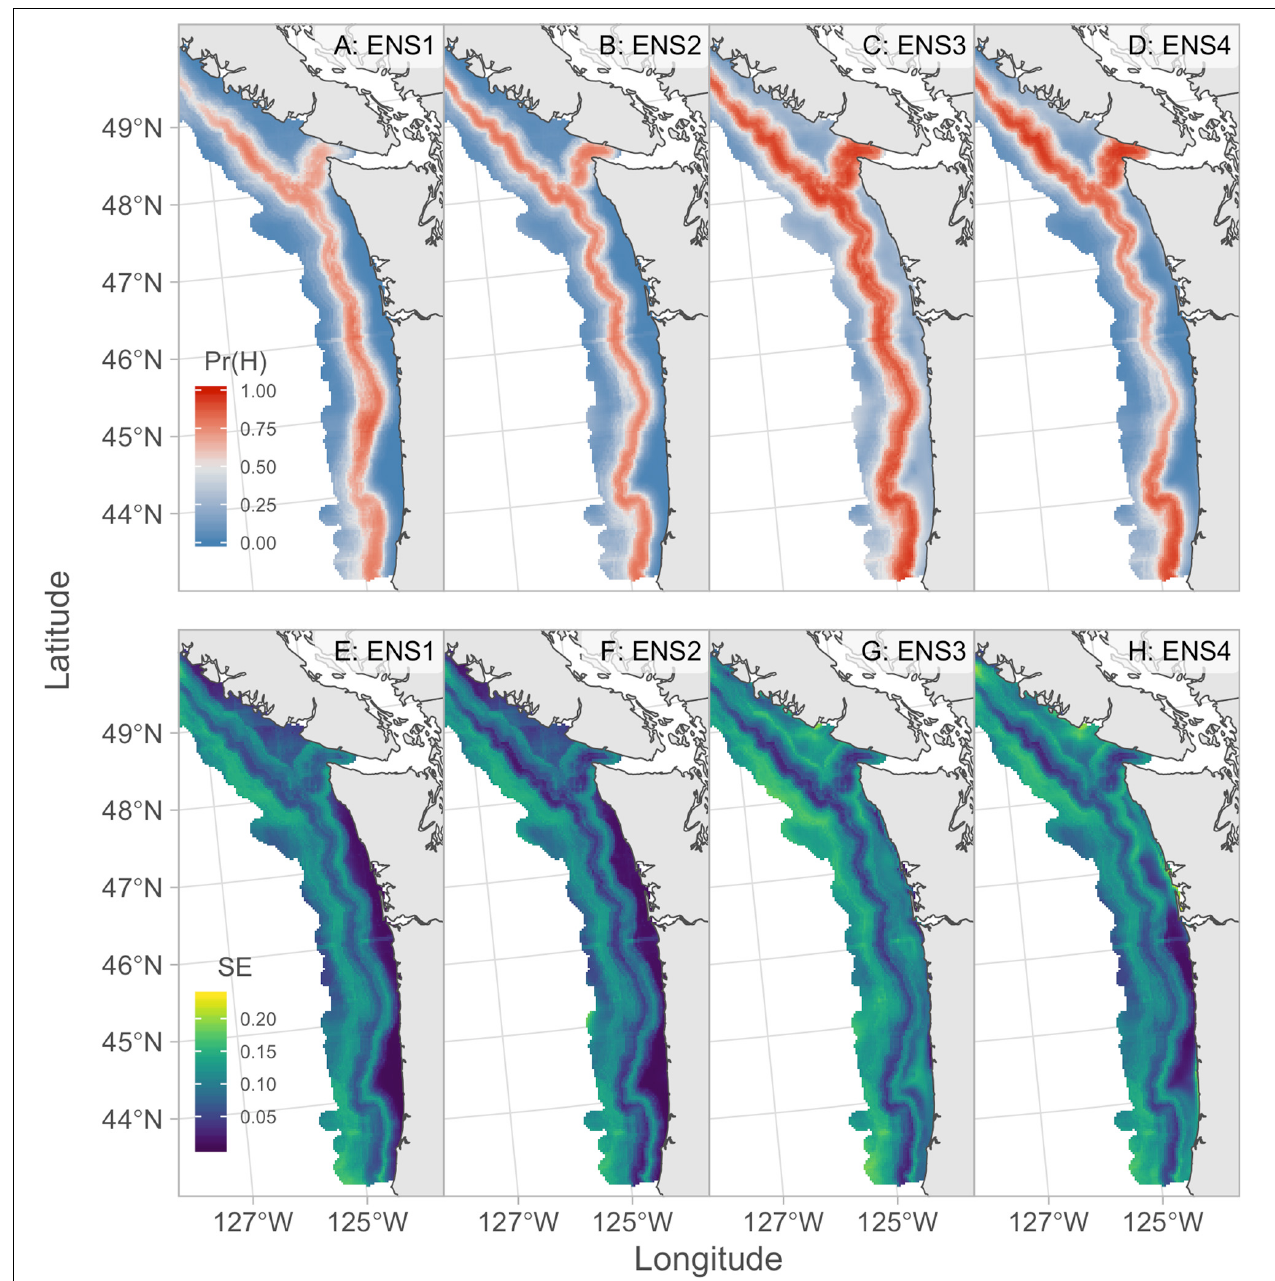
FIGURE 5 | August 2019 forecasts of hake occurrence from ensemble forecast models. Top row (A–D) shows the probability of hake occurrence where red indicates probabilities greater than 0.5 and blue indicates probabilities less than 0.5. Bottom row (E–H) shows the associated standard errors for each model where brighter colors indicate higher forecast